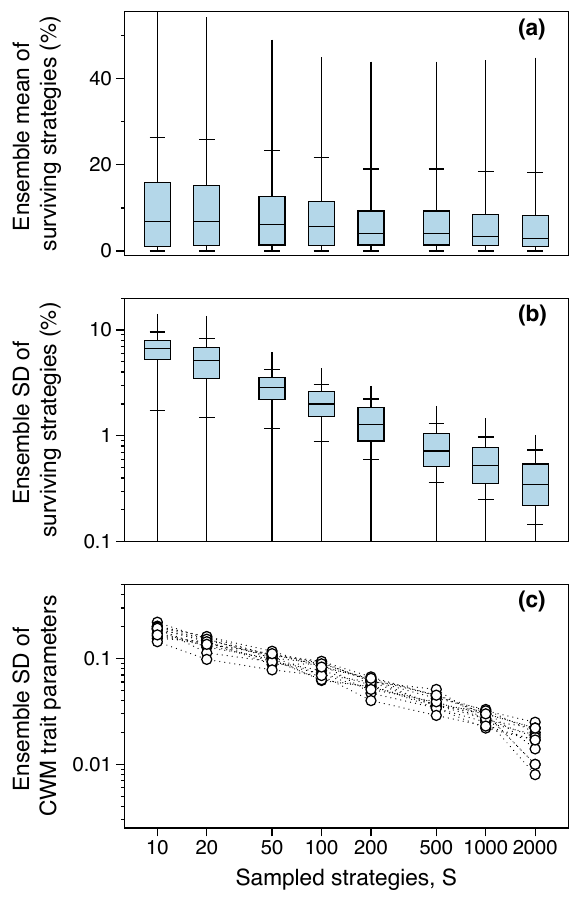
Fig. 10. (a) Box plots showing the geographic variation of the en- semble mean of the percent of surviving strategies. (b) Box plots showing decreasing ensemble standard deviation of the percent of surviving strategies with increasing number of sampled strategies, S . Each ensemble contains 20 JeDi-DGVM simulations with the same number of randomly sampled growth strategies ( S = 10, 20, 50, 100, 200, 500, 1000 or 2000). Central boxes show the interquar- tile range and median across all (a) non-glaciated and (b) vegetated land grid cells; vertical lines indicate the range; horizontal whiskers indicate the 10th and 90th percentiles. (c) Line plots showing de- creasing ensemble variation of the abundance-weighted trait values with increasing number of sampled strategies ( S ). Each circle rep- resents the area-weighted spatial mean of the ensemble standard de- viation of the community-weighted mean trait values for one of the 15 functional trait parameters.